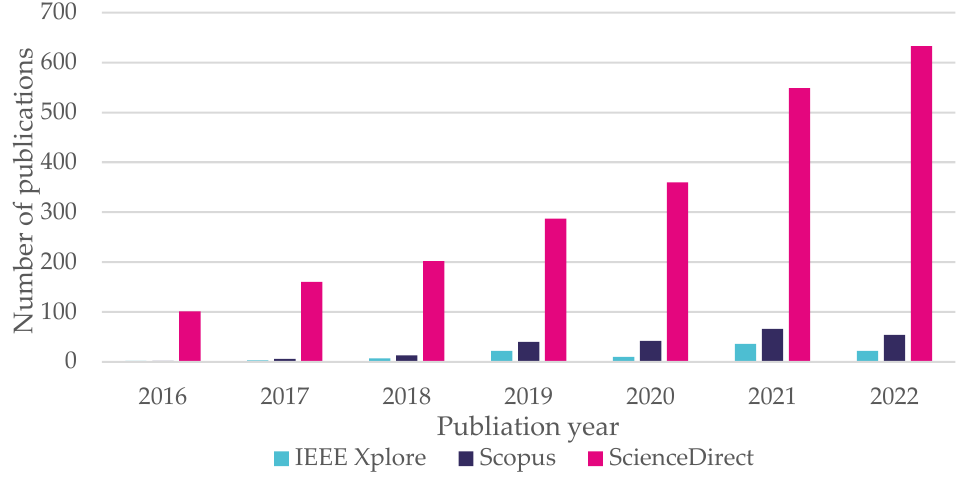
Figure 2. Search results for publications related to DT in automotive applications during the period 2011 – 2022 in ScienceDirect and Scopus.